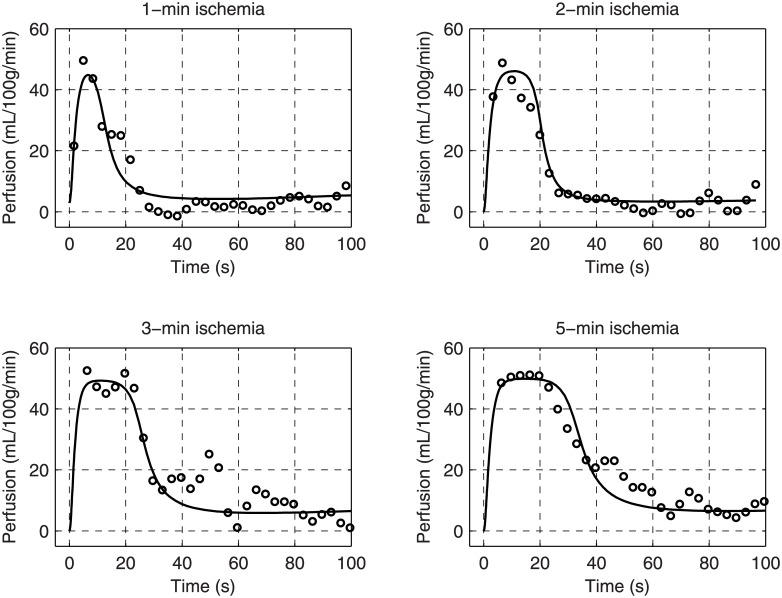
Fitting the responses of a healthy subject with the model.The resulting parameters are: [fr, gATP, gado, τATP, τado, τp] = [5.59, 14.67, 3.49, 18.0, 44.5, 3.05].